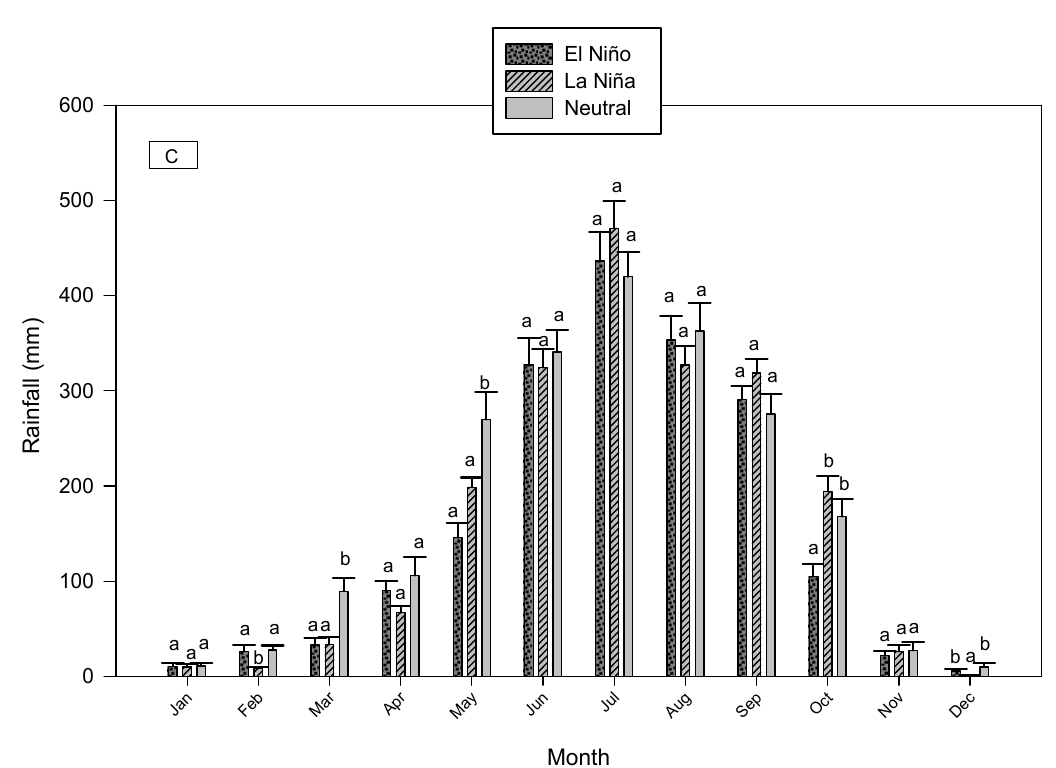
Figure 2. Average monthly variations of maximum temperature ( A ), minimum temperature ( B ), and rainfall ( C ) for all selected stations in coastal Bangladesh. Means that do not share same letters are statistically significant (Tukey’s b, α = 5%). The error bars represent the standard error of the means.